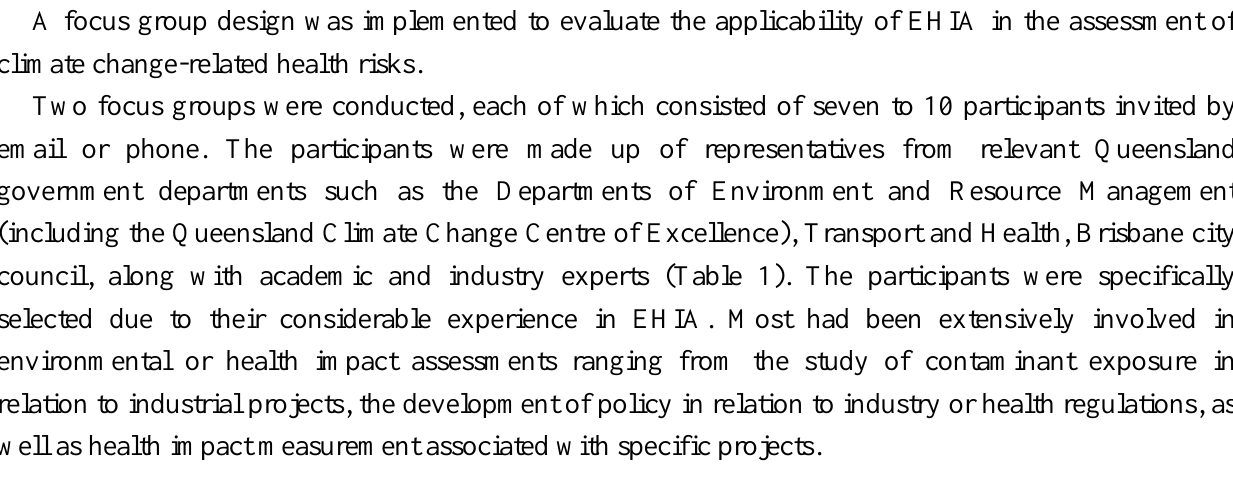
Table 1. Characteristics of focus group